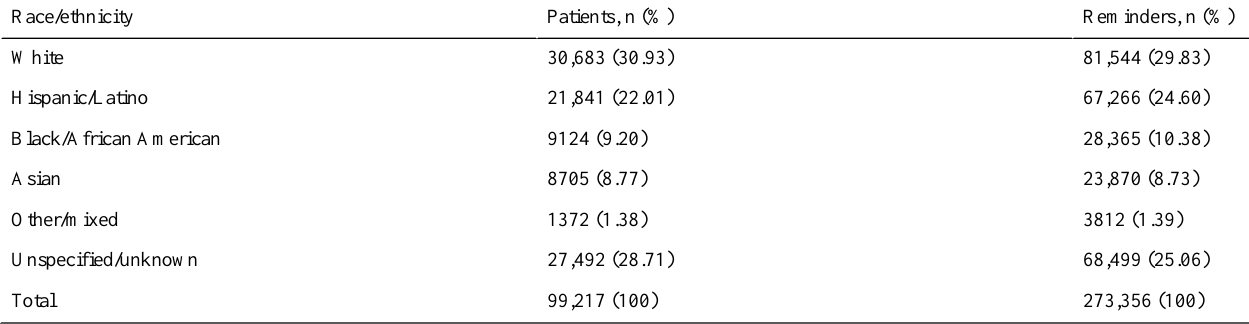
Table 2. Race/ethnicity of text messaging group.